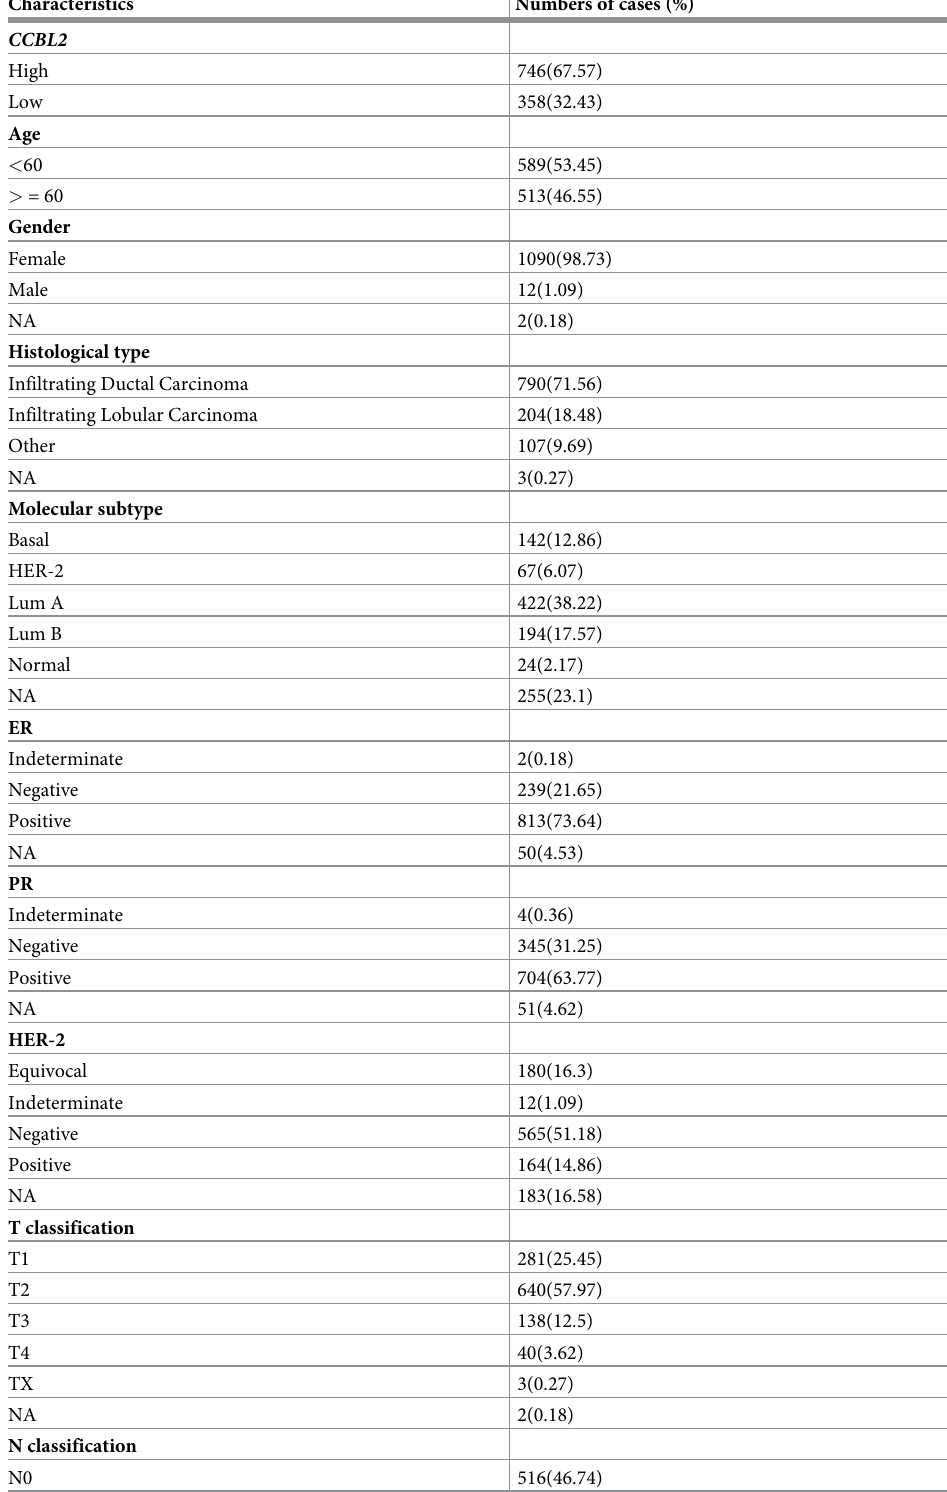
Table 1. Clinical characteristics of TCGA-BRCA level 3